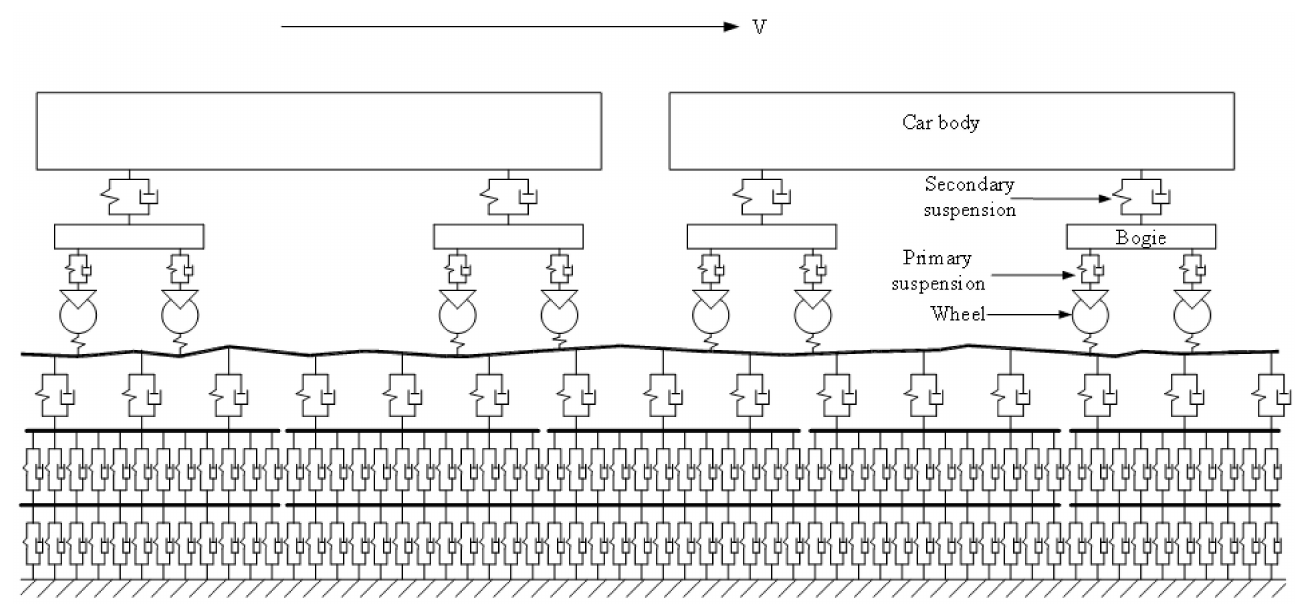
Figure 1. Schematic of train–CRTS III slab track–subgrade coupling dynamic